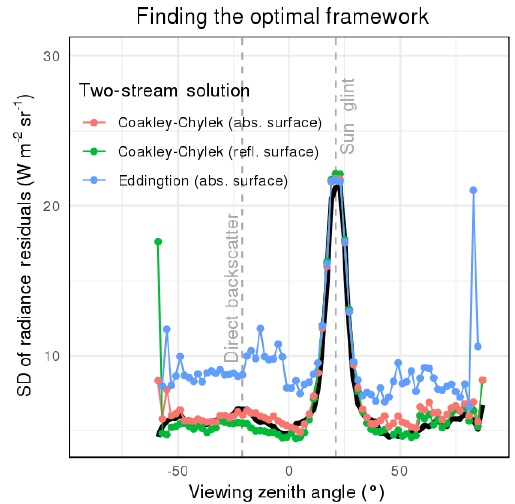
Figure 3. Applied to angular bins of the principal plane for θ 0 ∈ [ 20 ◦ , 22 ◦ ] , we test a variety of two-stream solutions for cloud albedo (Eqs. 10–12) as input to log-linear models as presented in Eq. (4). This plot shows the SD of resulting residuals and com- pares against the state-of-the-art sigmoidal fit (black line). As la- beled, gray dashed lines mark the position of sun-glint and direct